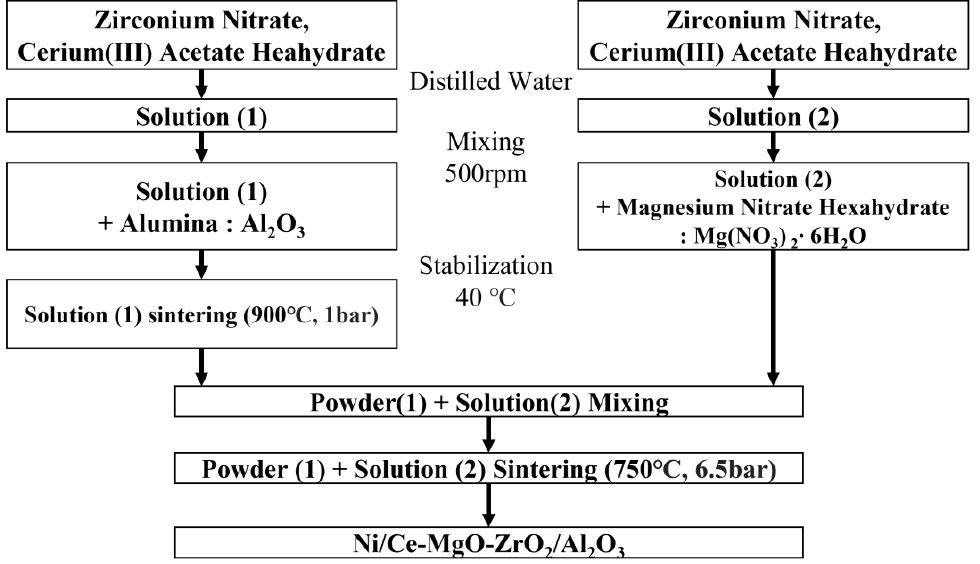
Figure 1. Block diagram detailing the synthesis process of 3 wt.% Ni catalyst for steam reforming of pyrolysis oil [38].